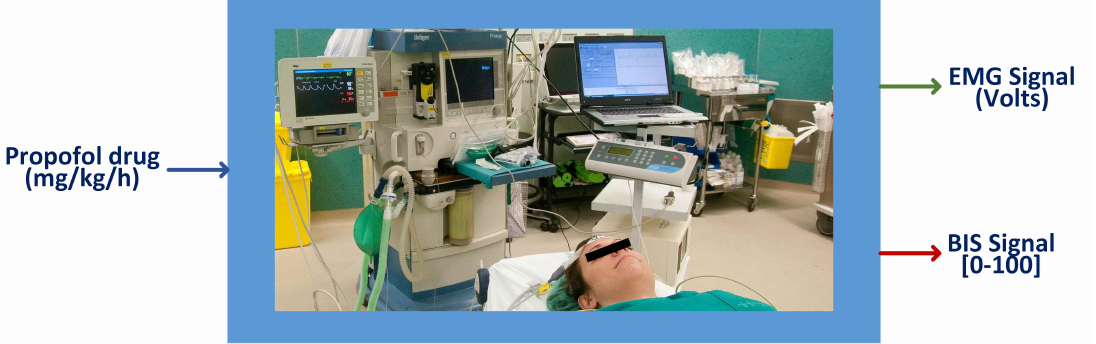
Figure 2. The anesthesia issue with a volunteer. Input and Output